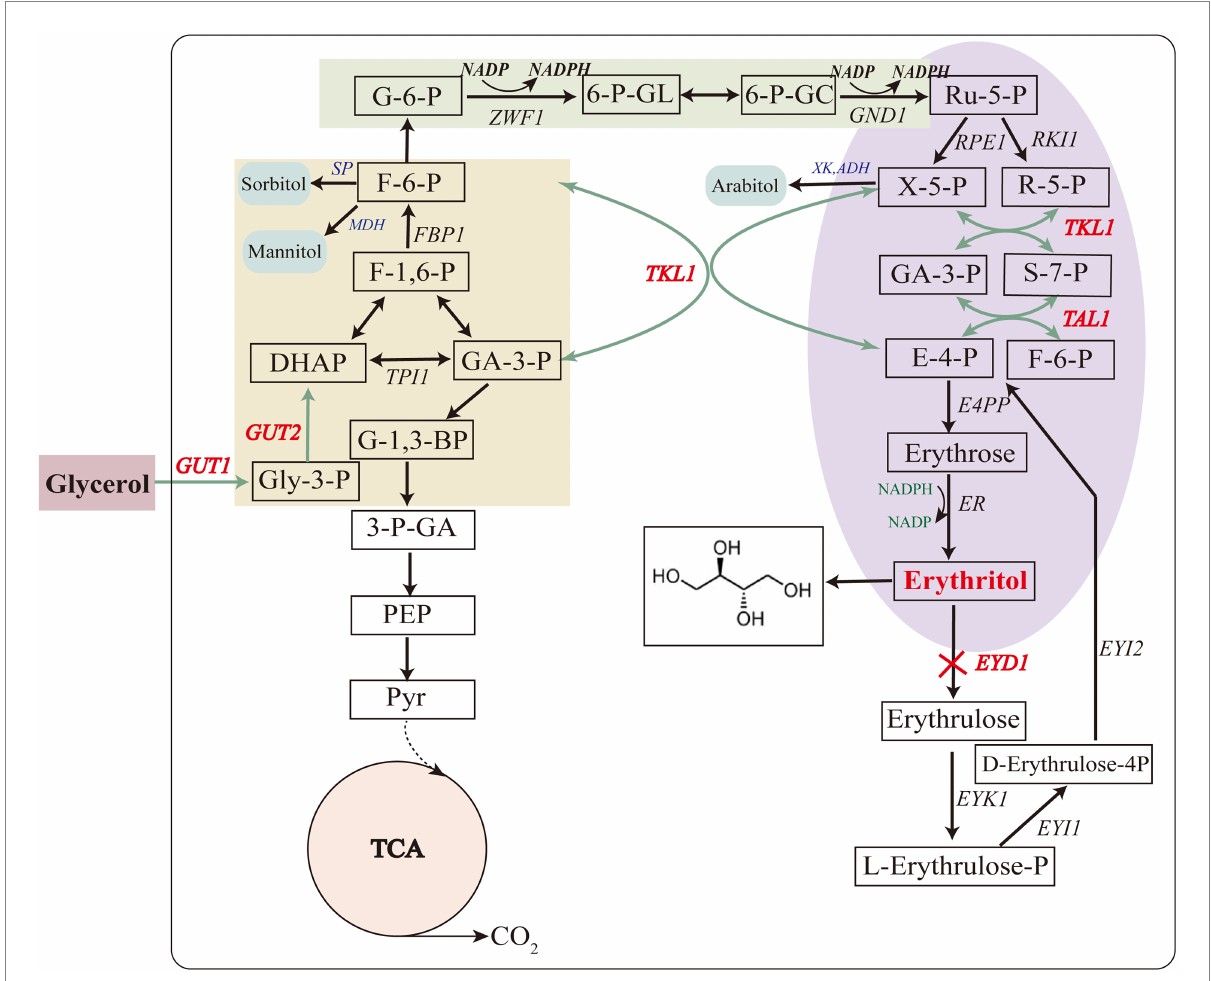
FIGURE 3 Metabolic pathway of erythritol biosynthesis on glycerol in Y. lipolytica . Genes marked in red and bold were selected for overexpression (except for EYD1 ) or disruption ( EYD1 ). GUT1 glycerol kinase, GUT2 glycerol 3-phosphate dehydrogenase, TKL1 transketolase, TAL1 transaldolase, EYD1 erythritol